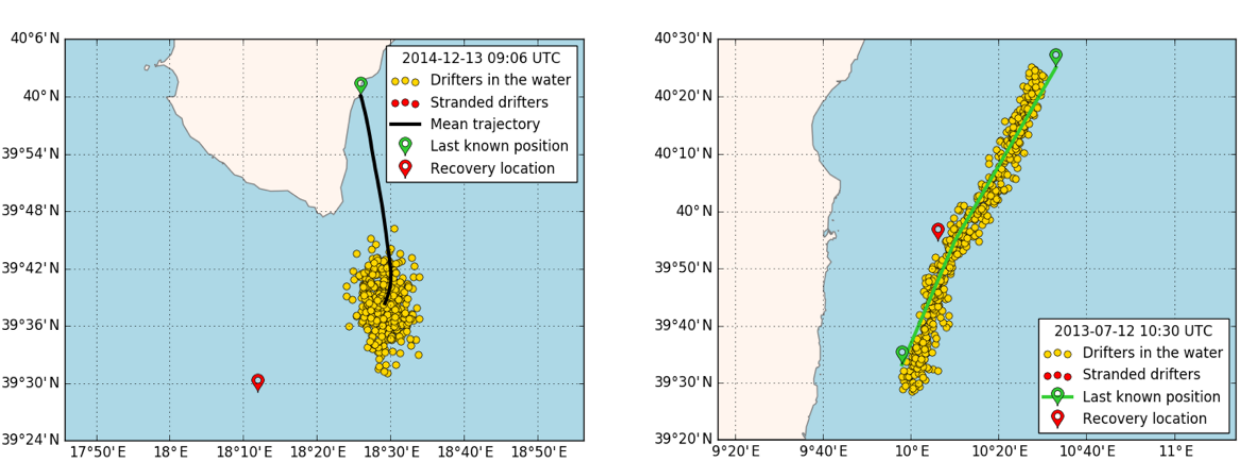
Figure 14. Results of the “small boat” simulation done using OCEAN-SAR showing the positions (yellow points) of the parti- cles at the end of the simulation 09:05UTC on 13 December 2014. The red place marker indicates the position at which the boat was rescued. The green place marker represents the last known position. The black line shows the mean trajectory of the simulated particles.